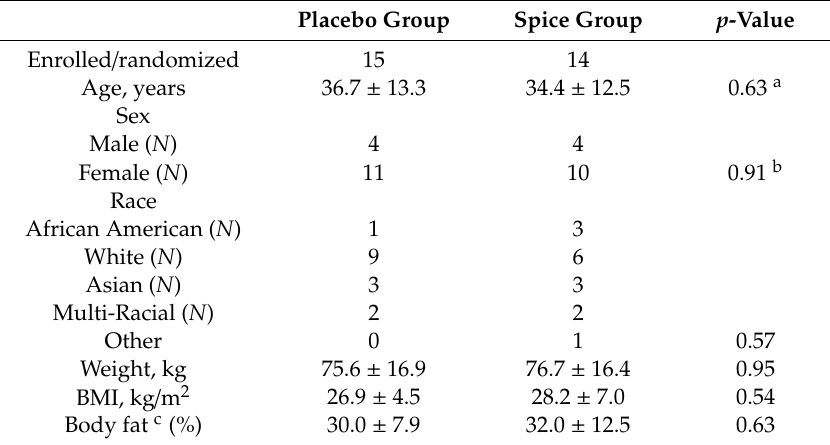
Figure 1. Flowchart of study subjects. A total of 31 subjects were randomized and completed study. Twenty-nine subjects were included in data analysis. Two subjects were excluded due to non-adherence to protocol. Table 1. Selected baseline characteristics of study